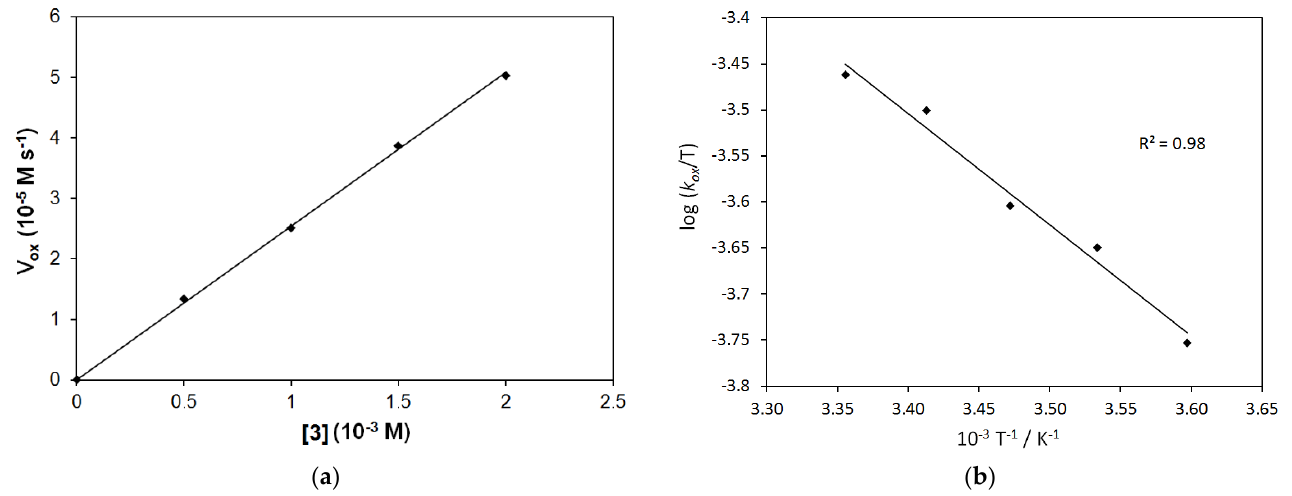
Figure 12. Stoichiometric 3 PhIO – mediated Baeyer–Villiger oxidation of cyclohexanone. ( a ) Dependence of the reaction rates on the complex concentration [Cyclohexanone] = 0.35 M, T = 15 °C, the iron(III) intermediate ( 3 PhIO ) intermediate was generated with PhIO, in MeCN; ( b ) Eyring plots. [ 3 ] = 10 − 3 M, [cyclohexanone] = 0.35 M in MeCN, at different temperature.